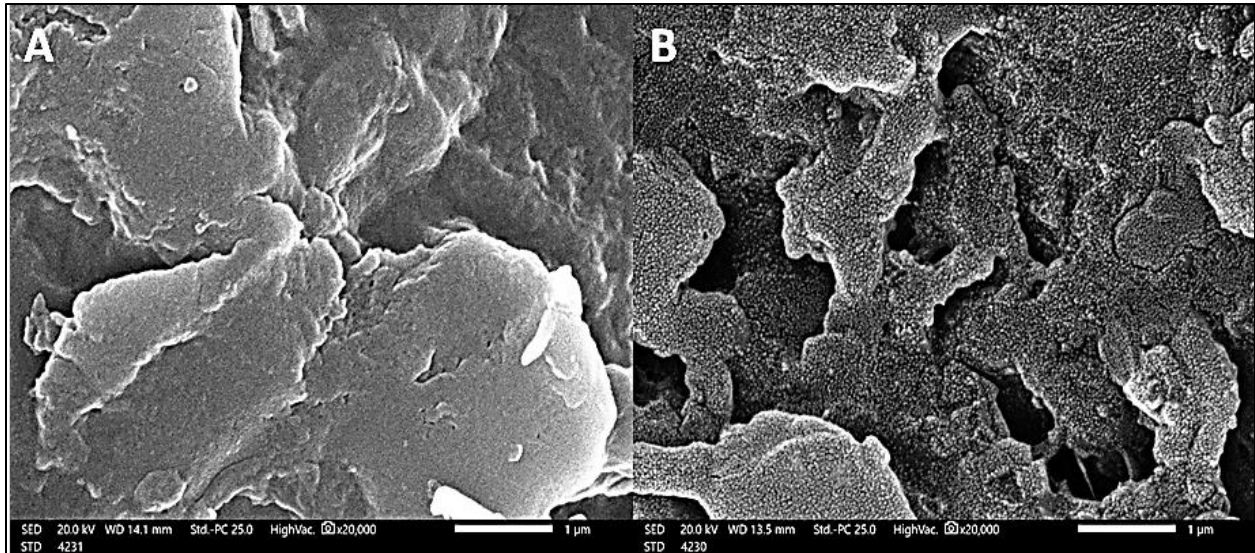
Figure 4. SEM micrographs of A. platensis nanoparticles before and after adsorption ( A , B , respectively) of methylene blue.